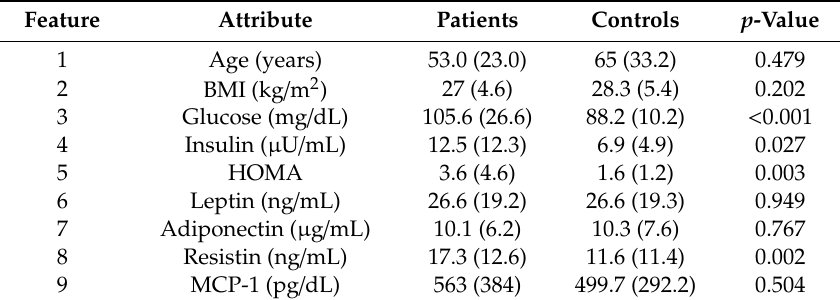
Table 1. Features in the original Coimbra Breast Cancer